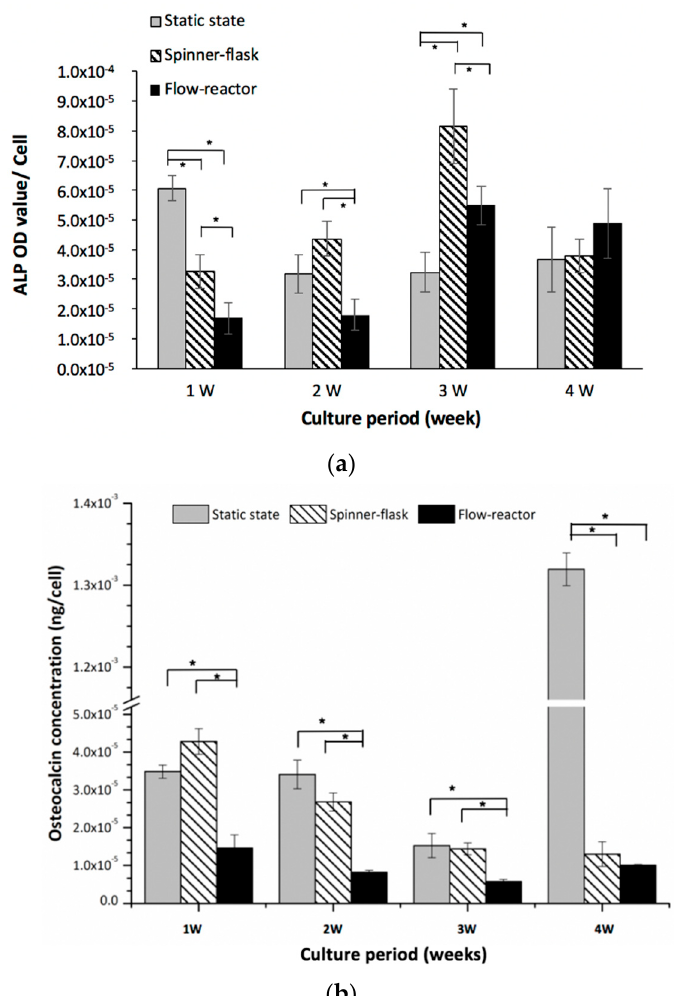
Figure 3. ( a ) alkaline phosphate (ALP) activity and ( b ) osteocalcin concentration in static-state, spinner-flask, and flow-reactor culture systems. The hMSCs cultured in the flow reactor had relatively lower ALP activity than those of the spinner-flask and static-state culture in the first two weeks; however, the ALP level increased dramatically at week three. Regarding the osteocalcin concentration, both the static-state and spinner-flask cultures had relatively higher levels in the first week and decreased gradually through the study while the static state had an extremely high level of osteocalcin at week four. Otherwise, the flow reactor maintained a stable osteocalcin